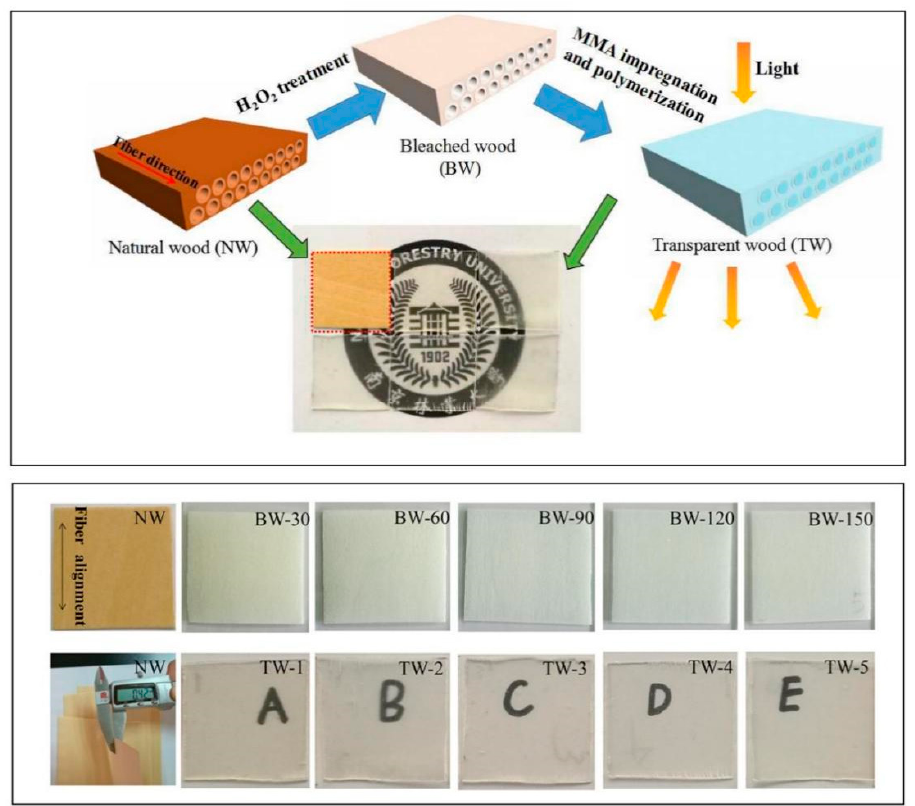
Figure 1. Schematic illustration of the preparation processes for transparent wood and finished 116 samples. 117